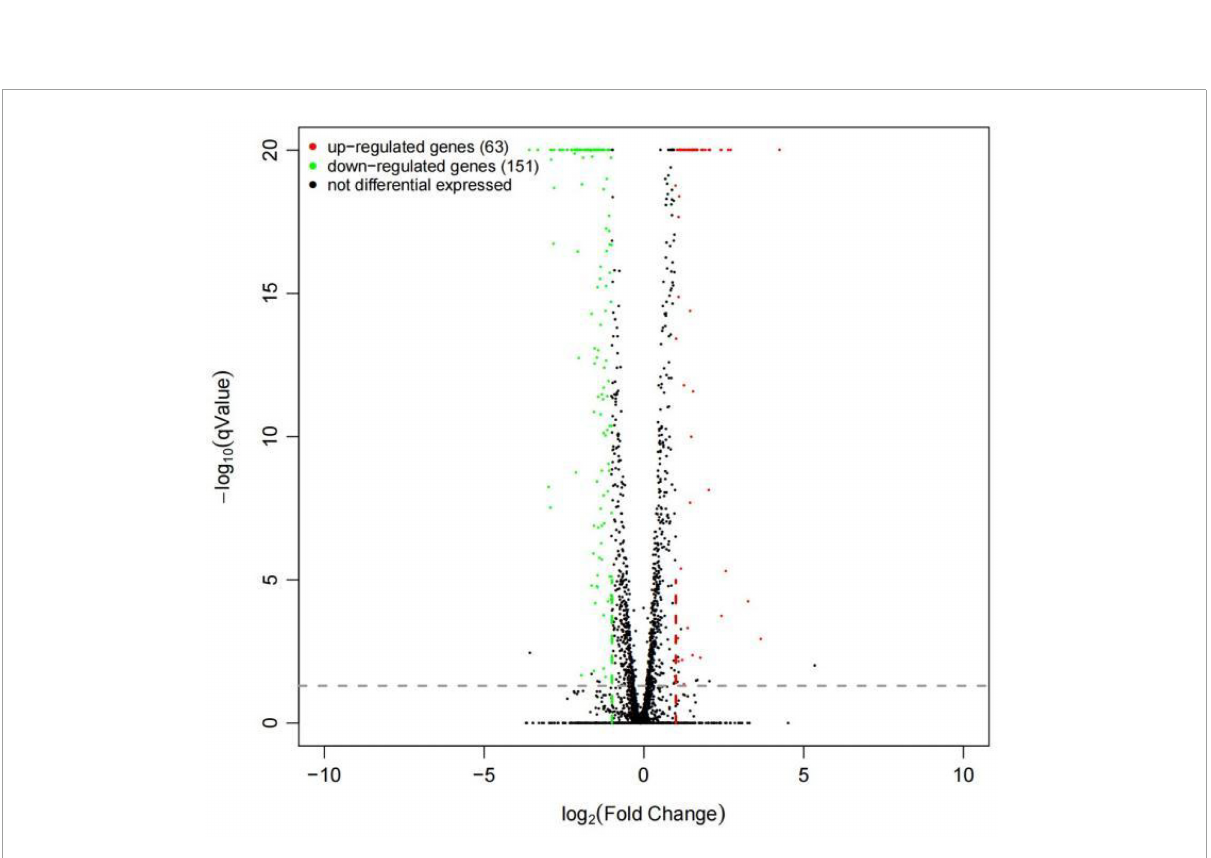
FIGURE3 Differential gene expression in Wyslmt cells in the context of Diquat degradation. Individual points correspond to specific genes, with upregulated, downregulated, and non-differentially expressed genes being shown in red, green, and black, respectively.